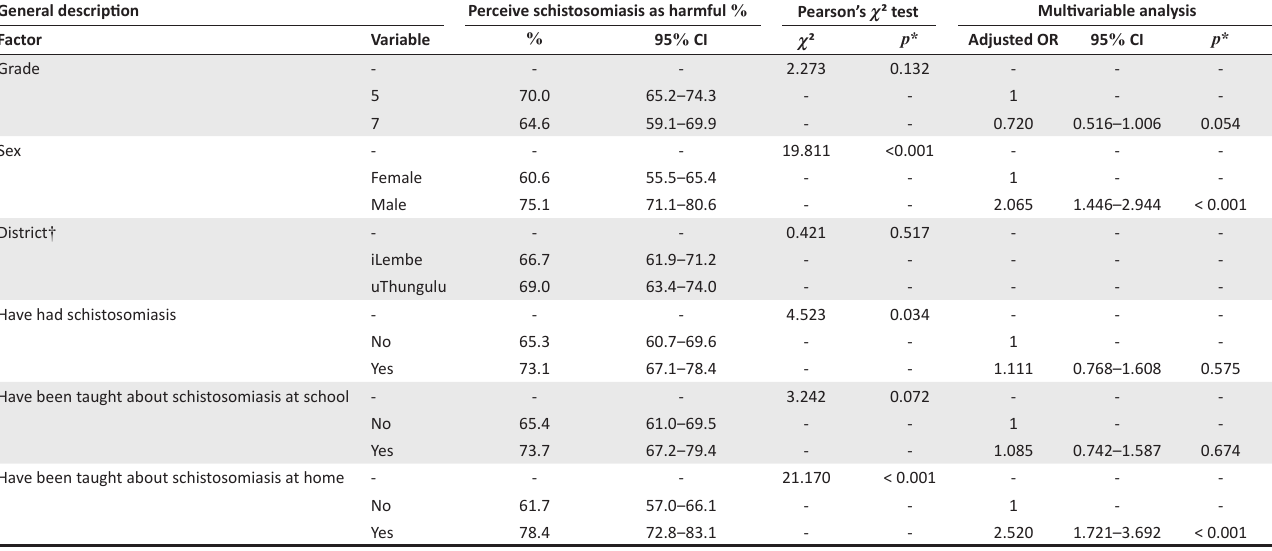
TABLE 2: Pearson’s χ² test and multivariable logistic regression analyses of factors affecting the perception of schistosomiasis as harmful by learners. General description